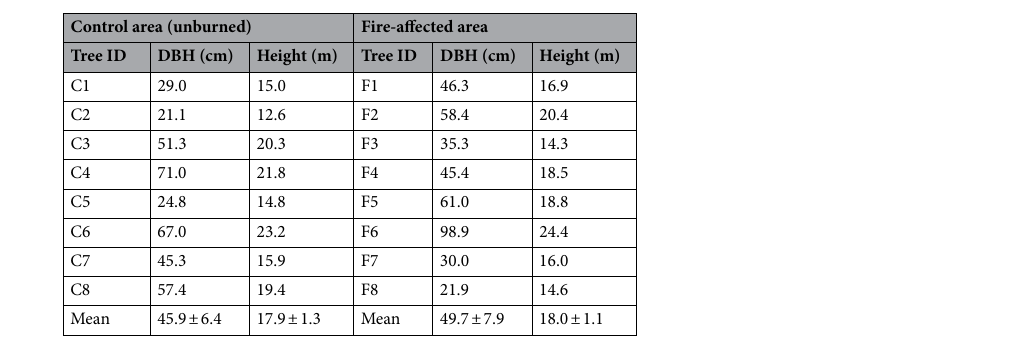
Table 1. Height a and diameter breast height (DBH) b of fire-affected and control beech trees. a Laser measured (TruPulse® 200; Laser Technology, Inc.; Centennial, CO, USA. b Measured approximately 130 cm above groundline.